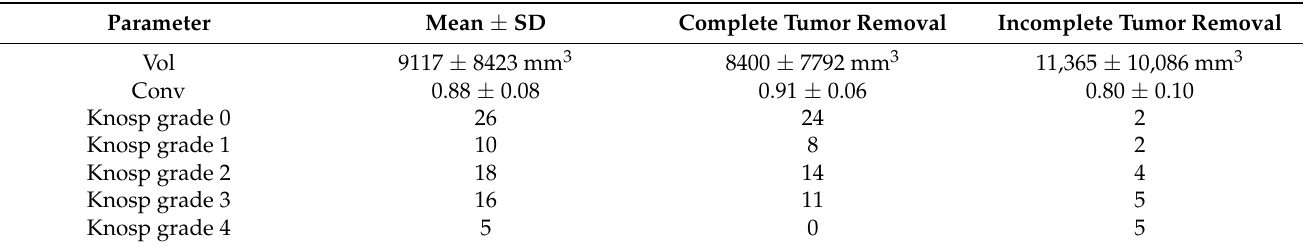
Table 3. Distribution of cavernous sinus (CS) invasion expressed by Knosp grade, tumor volume (Vol), and convexity (Conv) in relation to complete/incomplete surgical resection.